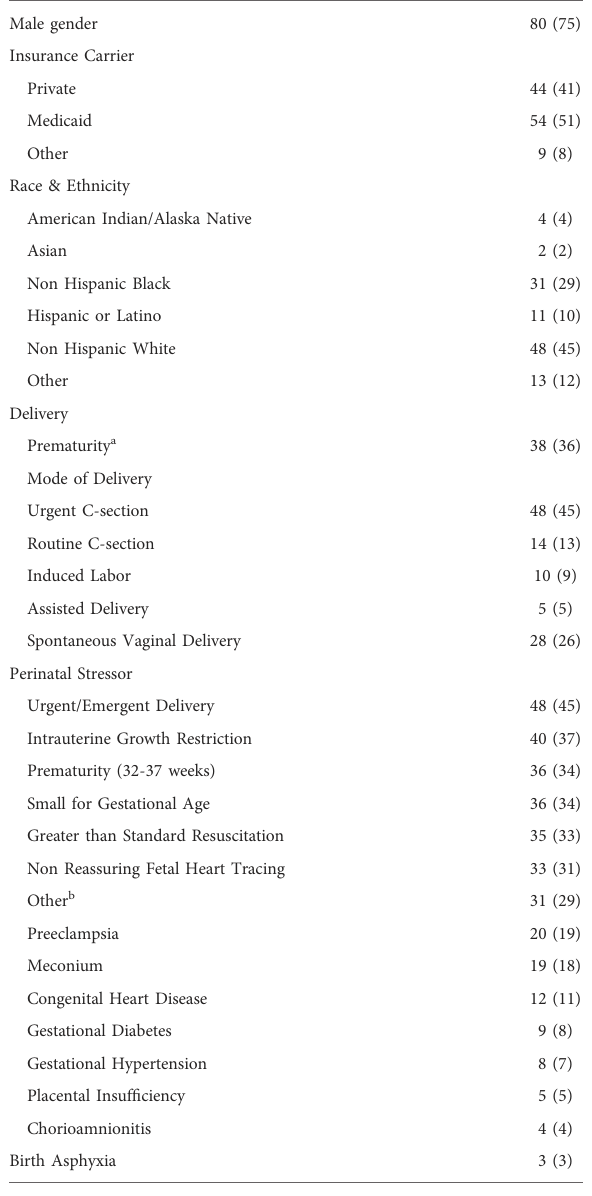
TABLE 1 Subject characteristics ( n